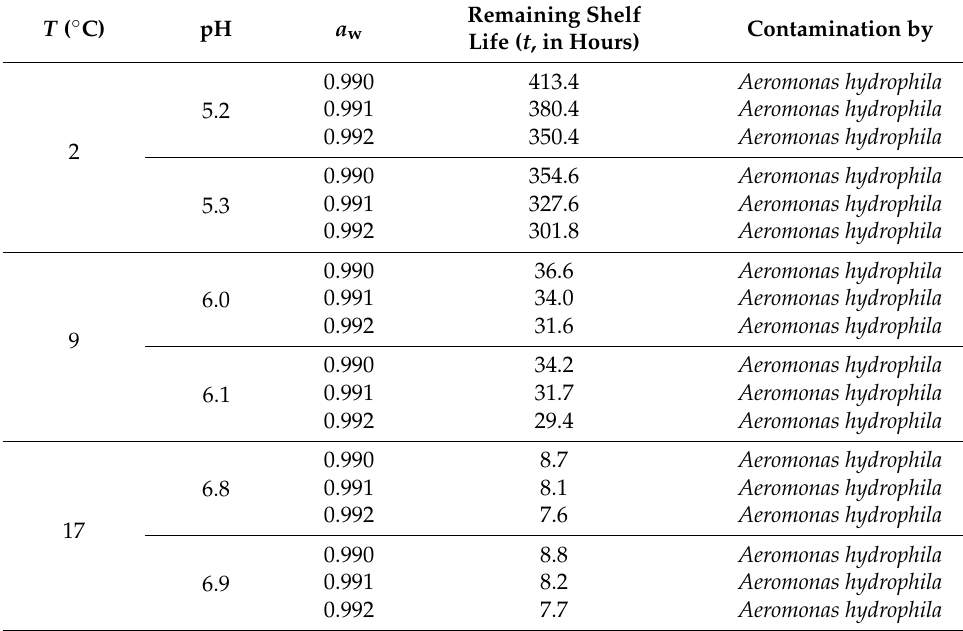
Table 9. Sampling of results of DSS—Remaining shelf life of cabbage.